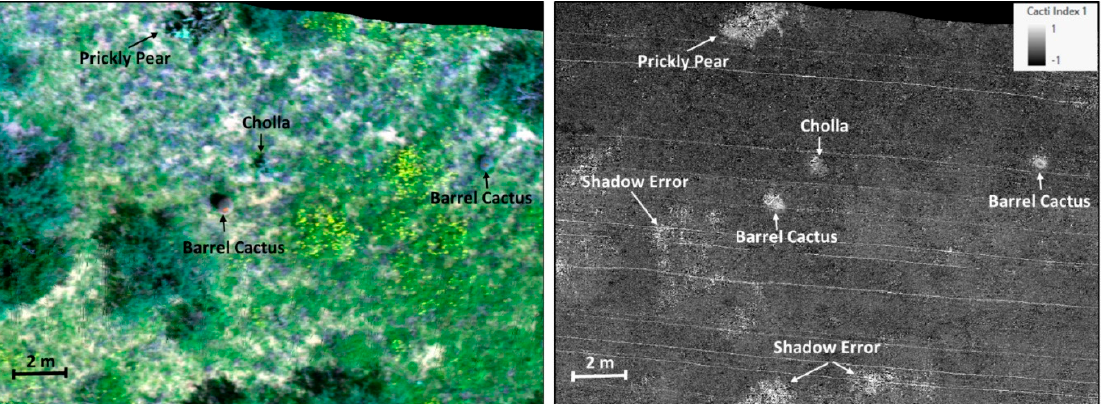
Figure 6. Drone ‐ mounted Nano hyperspectral imagery shown as true color ( left panel) and Cacti Index 1 ( right panel). Cacti were easily identifiable with the index; however, sensitivity problems near the edge of the sensor range created false high index values in low light shadowed areas of the study area.